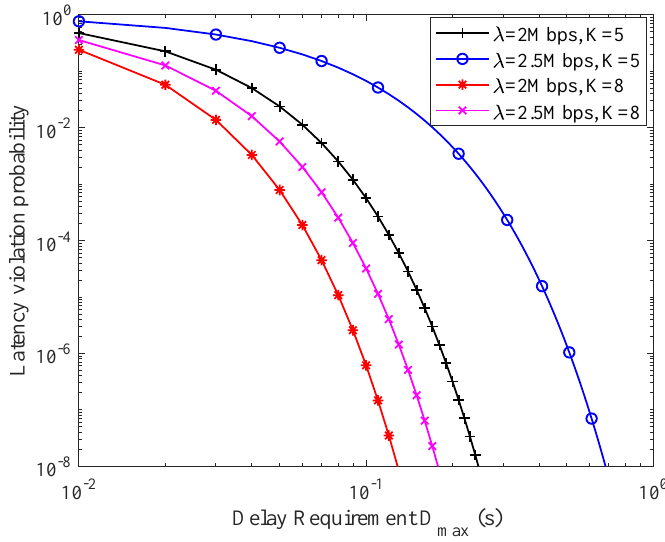
Figure 9. The relationship between network LVP and latency requirements.